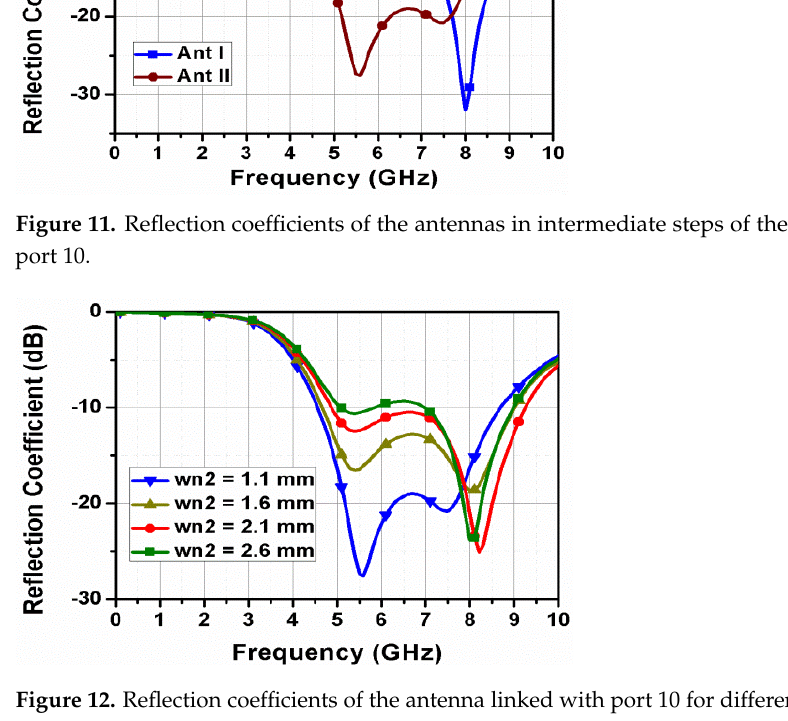
Figure 12 . Reflection coefficients of the antenna linked with port 10 for different values of wn2 .